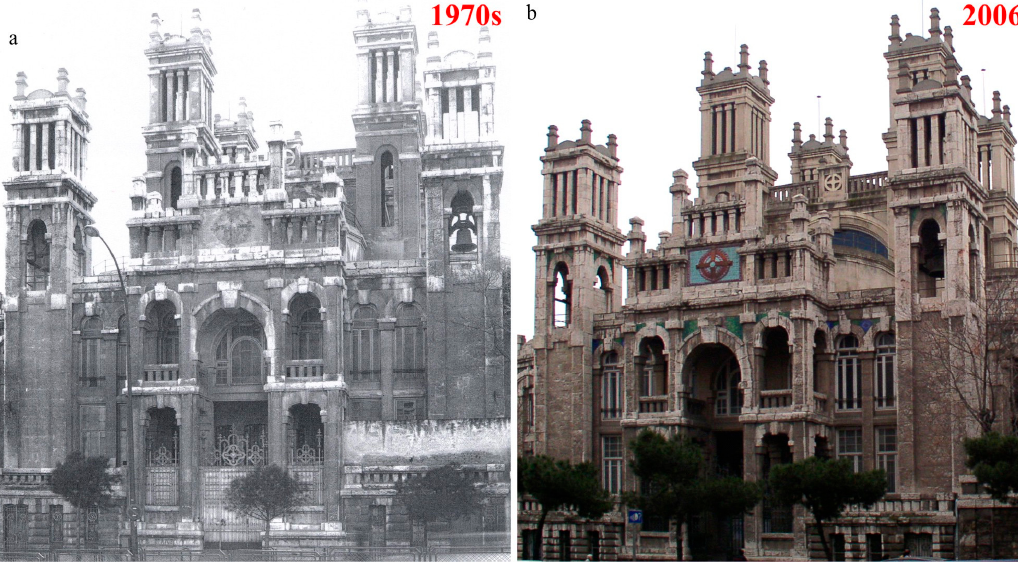
Figure 5. Soiling intensity causing aesthetic decay on the church portal ( a ) in/around the 1970s (courtesy of the Chartered Institute of Architects of Madrid’s Historic Archives Division); and ( b ) in 2006.